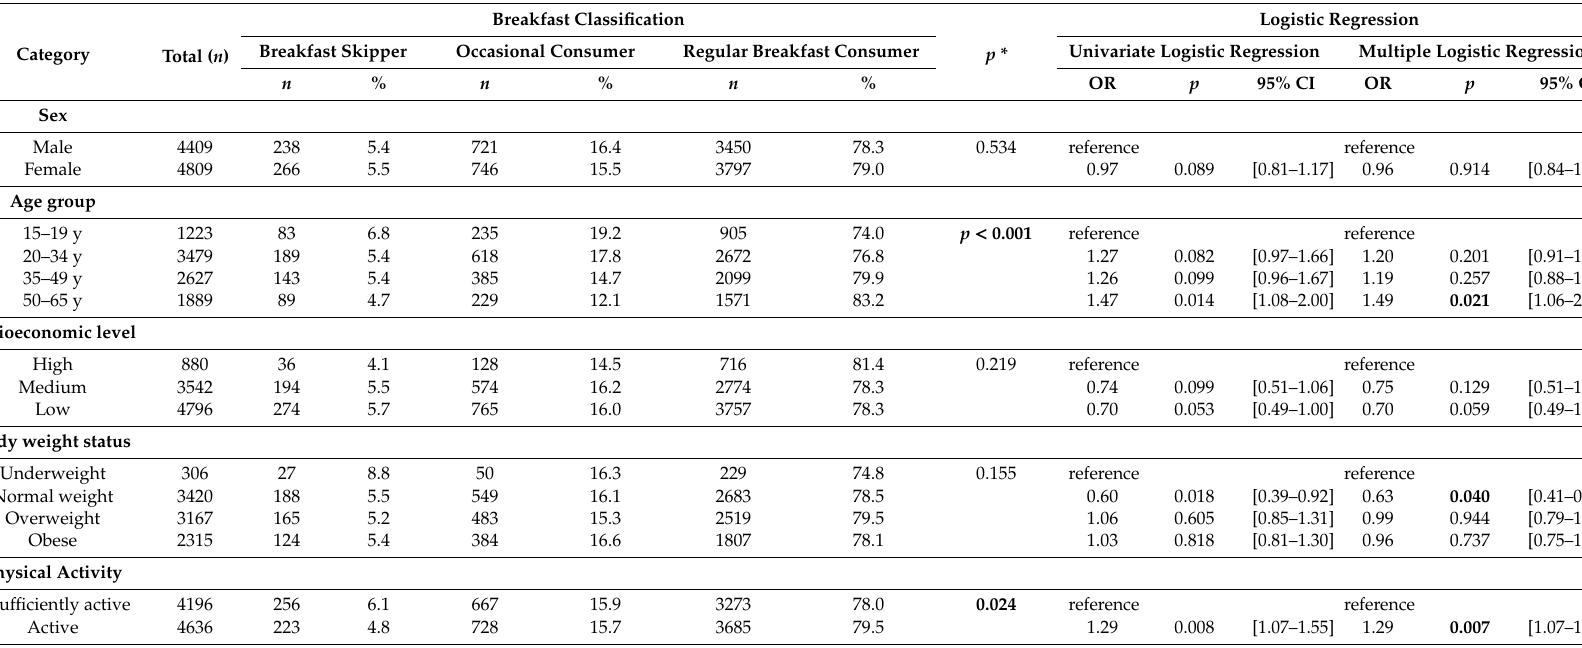
Table 1. Distribution of the ELANS (Latin American Study of Nutrition and Health / Estudio Latinoamericano de Nutrici ó n y Salud) participants according to breakfast consumption habit, sex, age group, socioeconomic level, body weight status and physical activity and analyses of the factors associated with breakfast